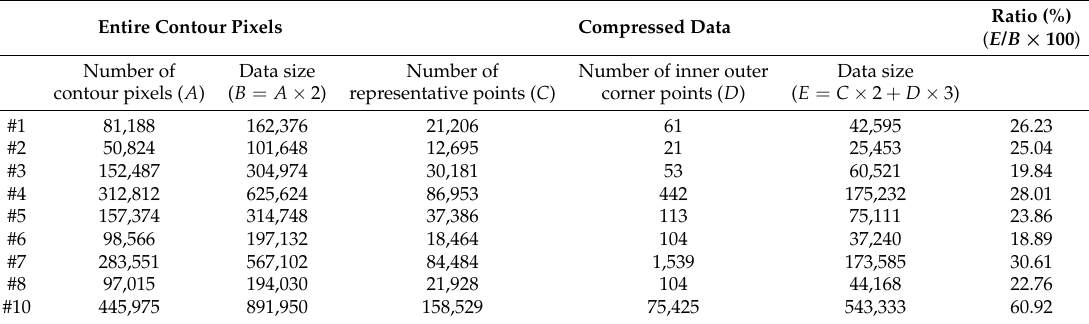
Table 9. Comparison between total contour pixels and representative points.